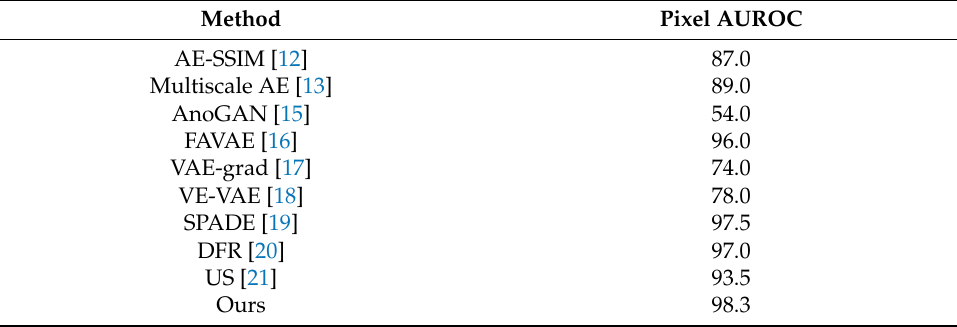
Table 2. Results for the carpet dataset (pixel AUROC).